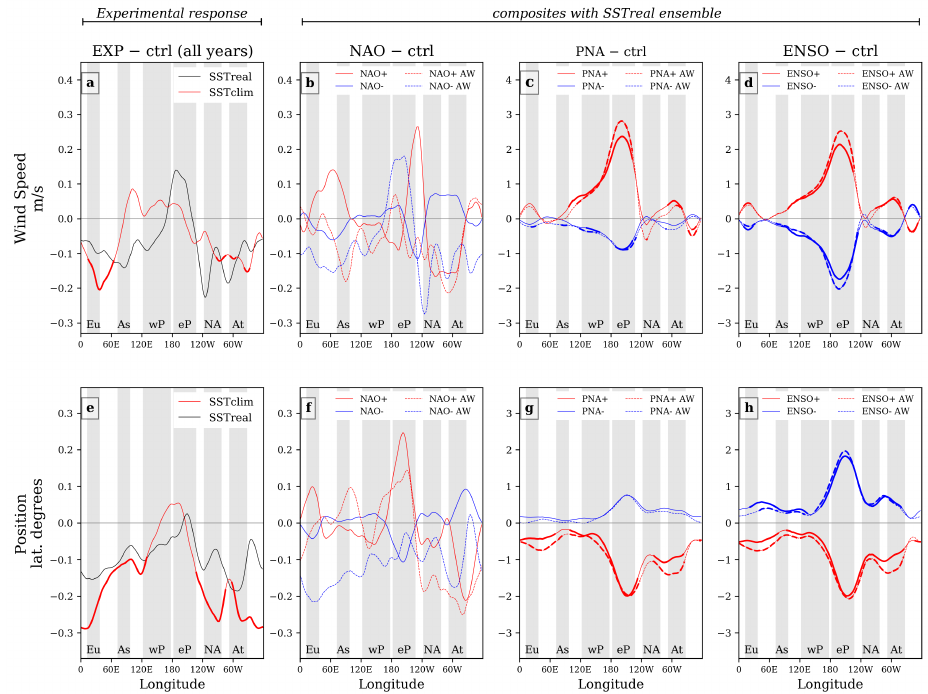
Figure 5. Experimental response and composite analysis for climatic oscillations of the winter STJ wind speed and latitudinal position, plotted as a function of longitude. ( a ) Wind speed differences between DJF ensemble means (experiment-control) for the SSTclim and SSTreal cases, ( b ) NAO composite analysis for wind speed from the SSTreal ensembles, ( c ) corresponding PNA analysis, and ( d ) corresponding ENSO analysis. The lower plots ( e – h ) are the same but for the STJ latitudinal position. Bold curves indicate regions where the differences are statistically significant at the 95% confidence